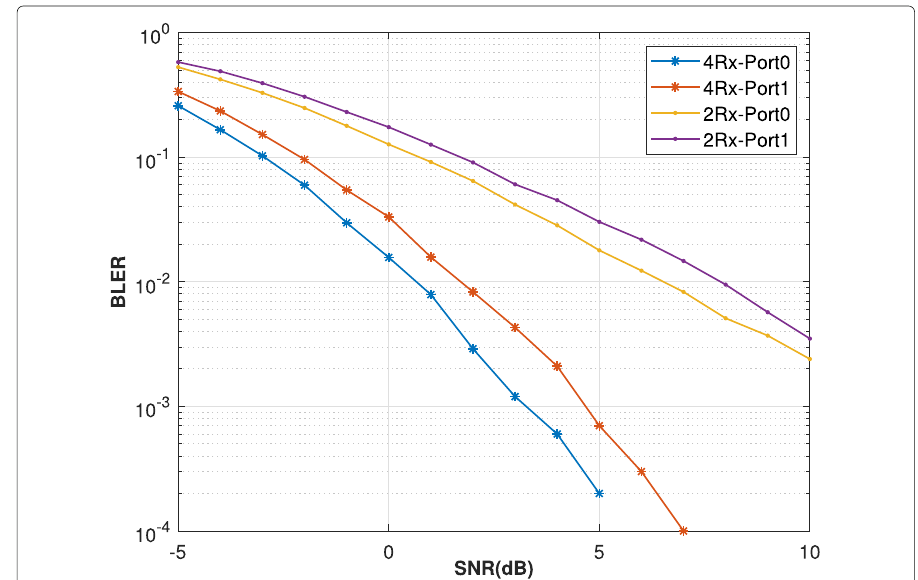
Fig. 22 BLER comparison of length-6 DMRS sequences on port 0 and port 1 with 3GPP transmitter design